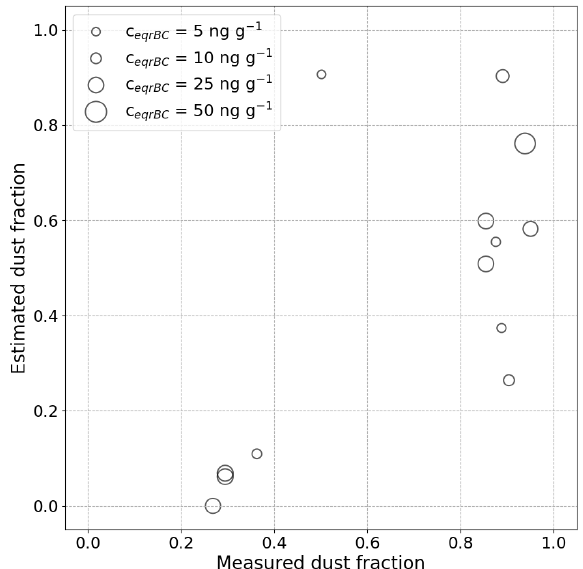
Figure 13. Comparison between measured and estimated propor- tion of LAP absorption coming from dust for all the ZOIs with con- comitant LAP measurements. The size of symbols corresponds to the measured eqBC concentration of the associated